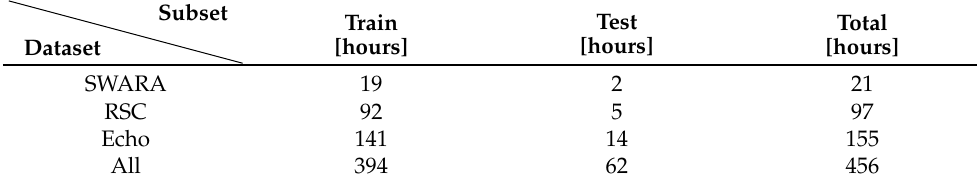
Table 6. Training and evaluation datasets